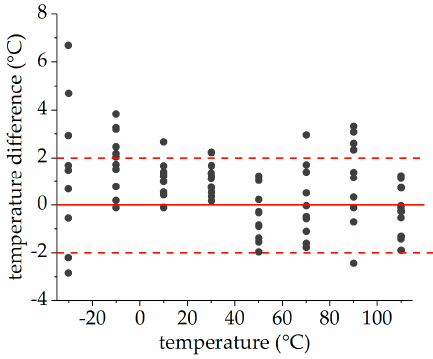
Figure 13. Deviations of FBG temperature to reference temperature.